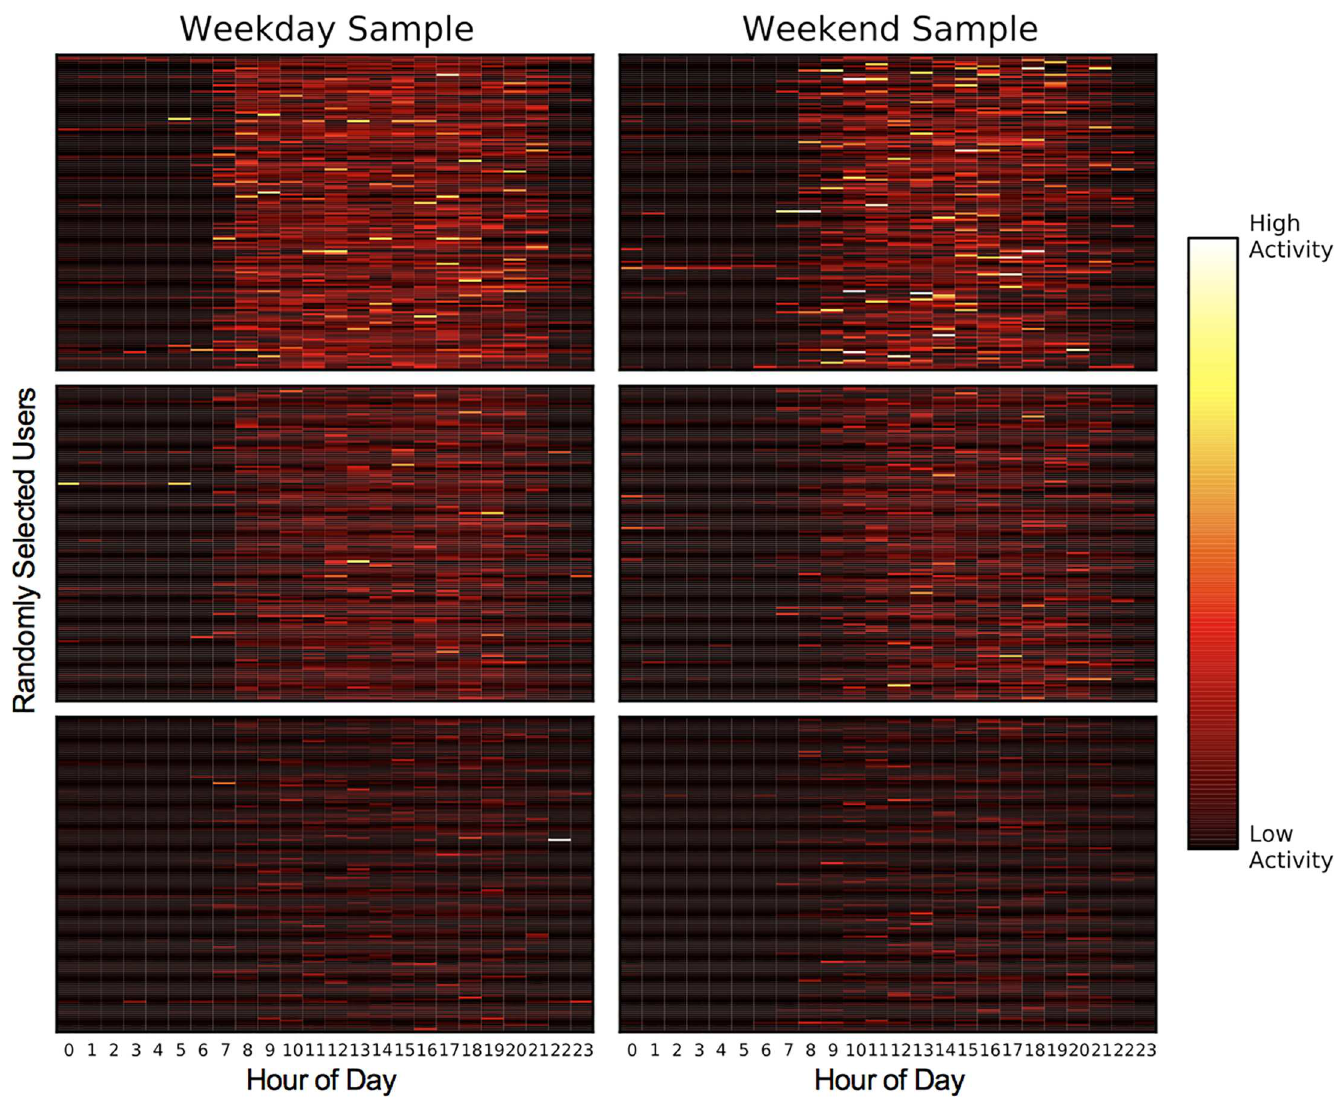
Fig 4. A random sample of 150 users from each of the weekday and weekend clusters: users in the active clusters were, on aggregate, happier than those in the less active